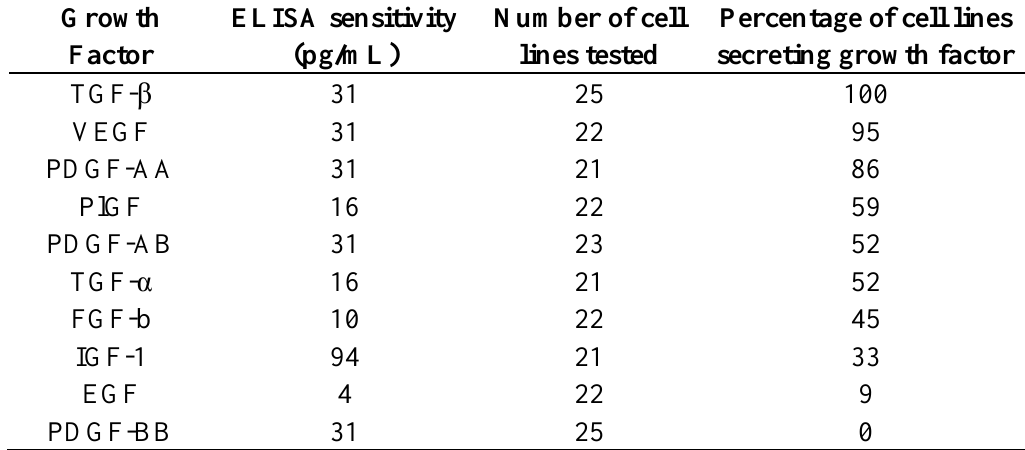
Table 2. Incidence of growth factors detected in the spent medium of human melanoma cell lines after seven days of